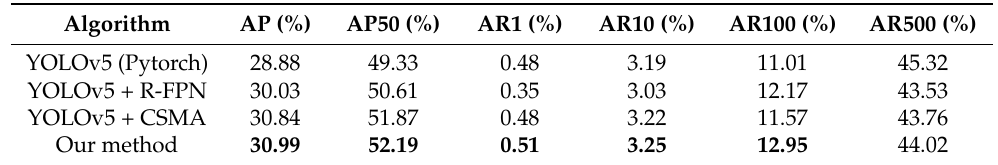
Table 2. Detection Precision of Different